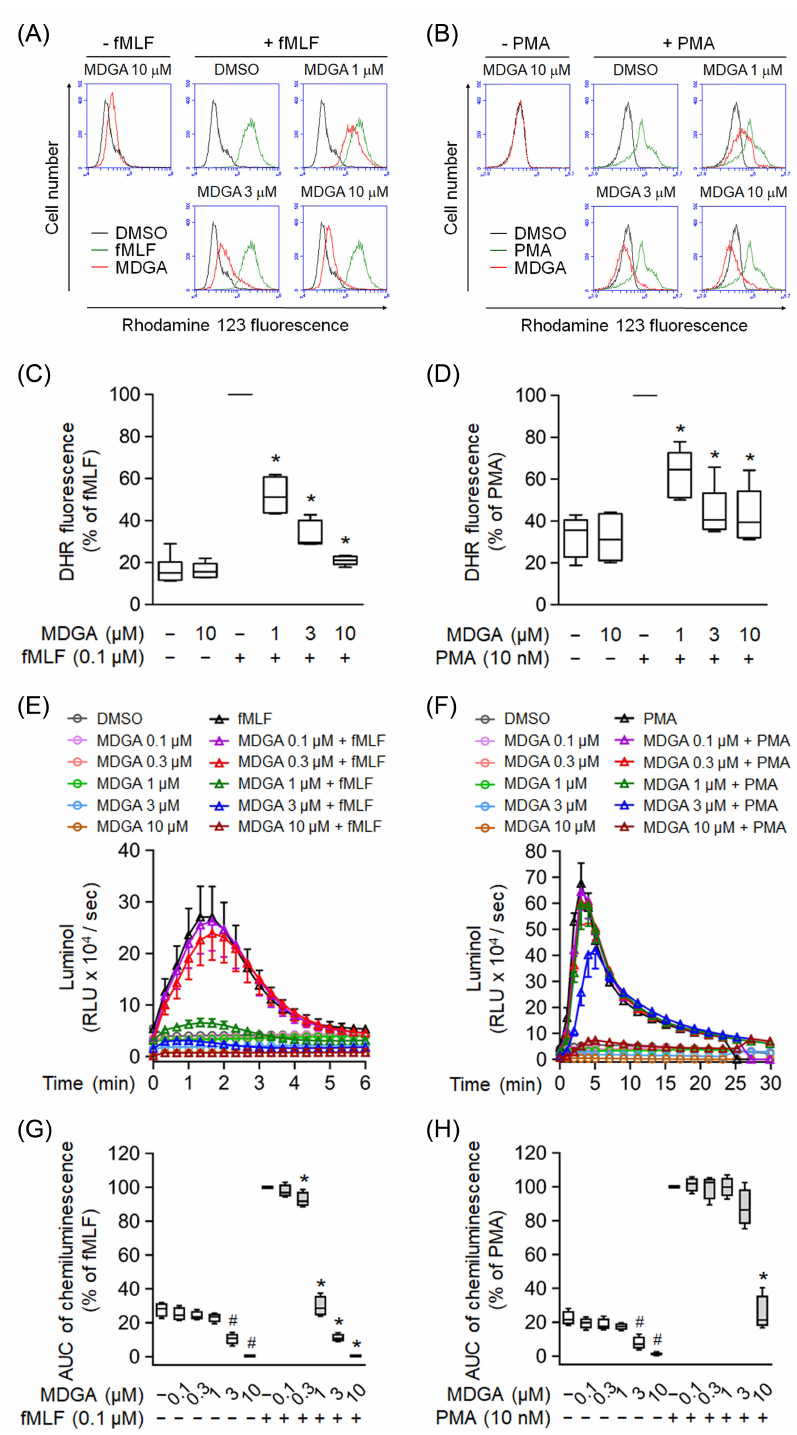
Figure 2. meso -Dihydroguaiaretic acid (MDGA) reduces reactive oxygen species (ROS) generation in activated human neutrophils. Dihydrorhodamine 123 (DHR123)- or luminol-incubated neutrophils were incubated with DMSO (0.1%, as control) or MDGA (0.1–10 µ M), and activated by fMLF (0.1 µ M) or PMA (10 nM). ROS production was detected by flow cytometry or chemiluminometer. The mean fluorescence intensity of ( A , B ) was quantified and shown in ( C , D ), respectively. The AUC value of ( E , F ) was quantified and shown in ( G , H ), respectively. The values are shown as the mean ± S.E.M. ( n = 6). # p < 0.05 vs. non-stimulated control; * p < 0.05 vs. stimulated